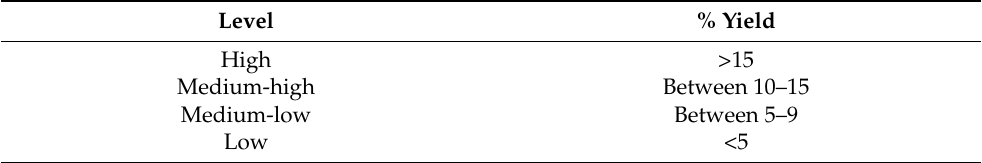
Table 1. Color legend of different levels of percentage yield of